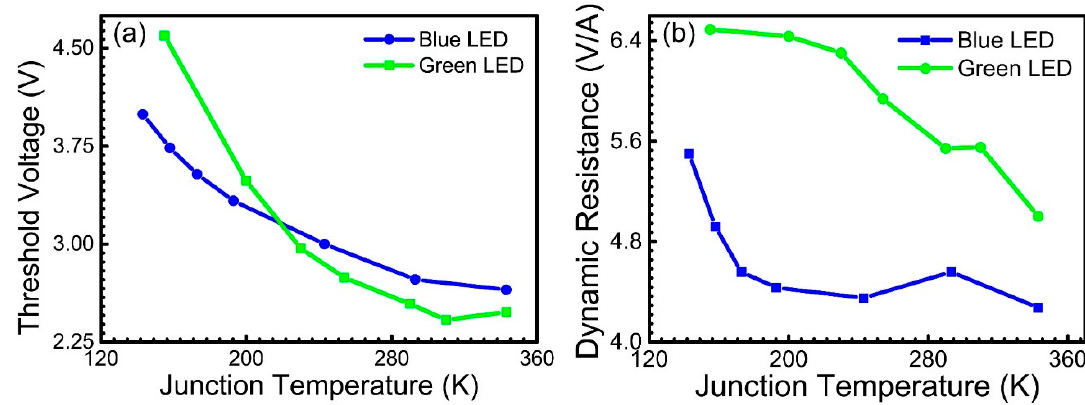
Figure 11. ( a ) Relationship between the threshold voltage and T j . ( b ) Relationship between the dynamic resistance and T j .